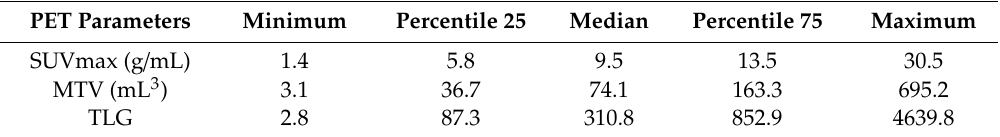
Table 2. In this table; 18F-FDG PET / CT semi-quantitative parameters: SUVmax, metabolic tumor volume (MTV) and total lesion glycolysis (TLG) values.